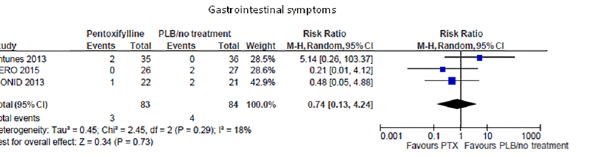
Fig 7. Risk of gastrointestinal symptoms in pentoxifylline vs. placebo/standard treatment.